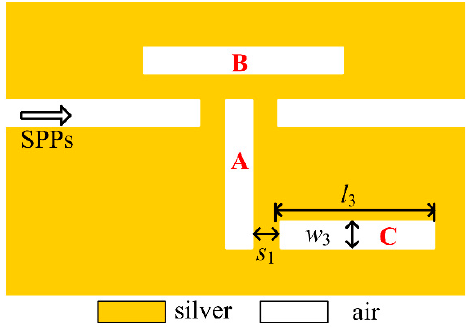
Figure 5. Schematic diagram of Fano resonant structure after adding cavity C .